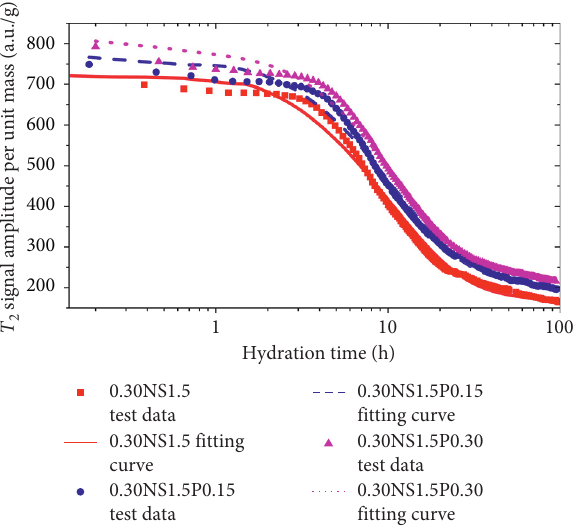
Figure 9: Experiment data and fitting results of cement pastes containing NS and